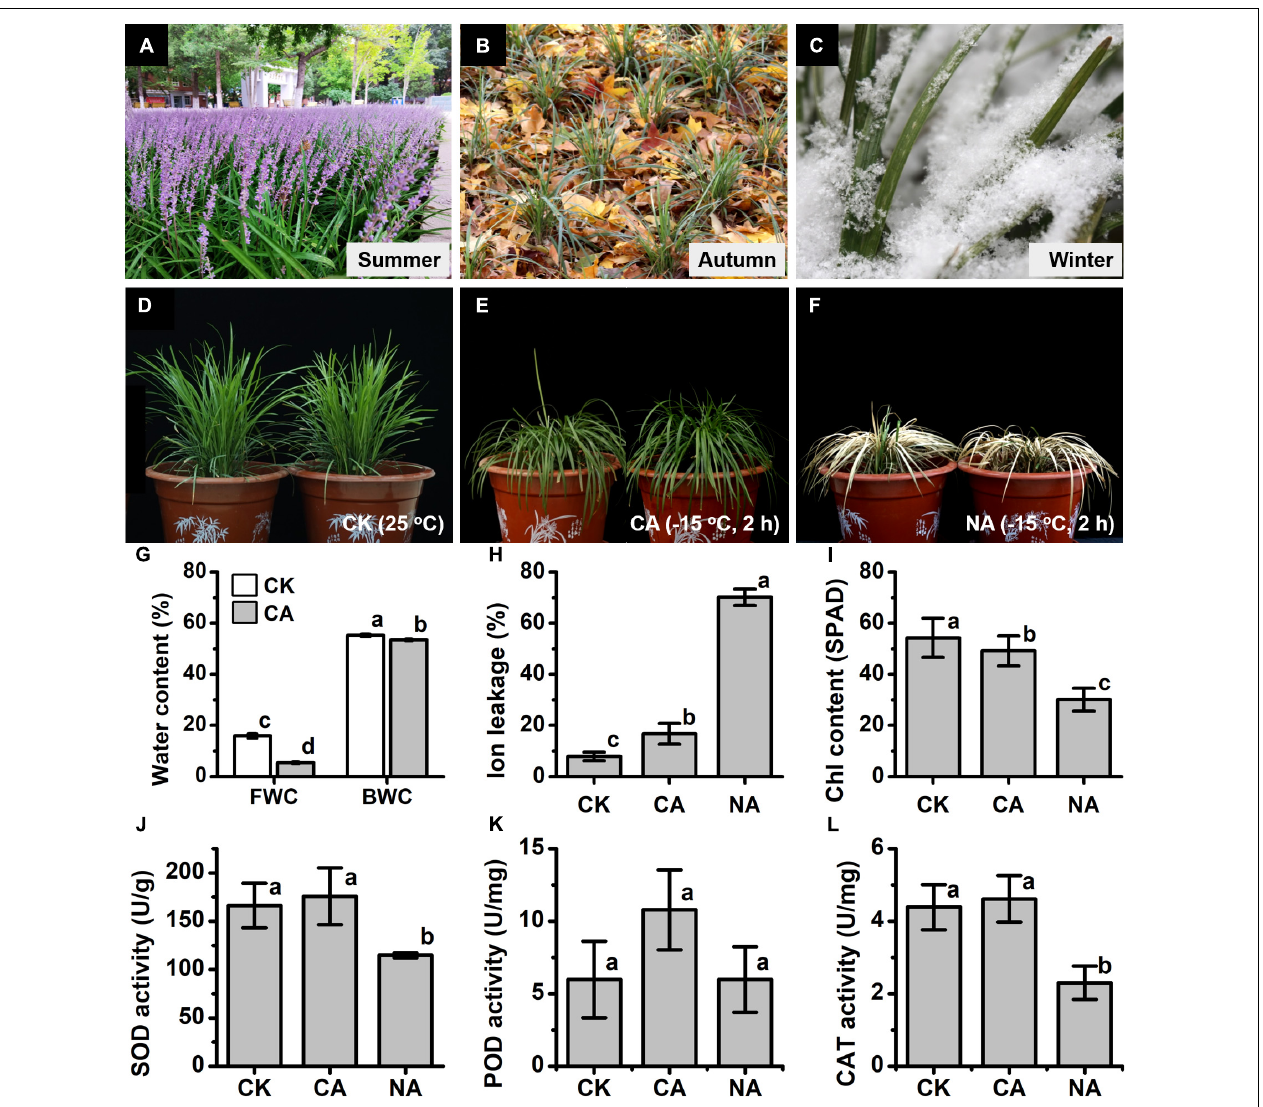
FIGURE 1 | Physiological and biochemical responses to the freezing stress in Liriope spicata . (A) Flowering landscape in summer. (B) Leaves of L. spicata do not turn yellow in autumn. (C) Leaves remain fresh and green when covered by heavy snow in winter. (D) Normal phenotype under 25 ◦ C (CK) condition. (E) Freezing phenotype under cold-acclimation (CA) conditions. (F) Freezing phenotype under non-acclimation (NA) conditions. (G) Water physiology. FWC, free water content; BWC, bound water content. (H) Ion leakage. (I) chlorophyll (Chl) relative content. (J) superoxide dismutase (SOD) enzyme activity. (K) Peroxidase (POD) enzyme activity. (L) Catalase (CAT) enzyme activity. CK, control samples that culture under 25 ◦ C; CA, freezing treatment samples under –15 ◦ C 2 h with 4 ◦ C CA for 3 days priority; NA, freezing treatment samples under –15 ◦ C 2 h without 4 ◦ C CA. The letters a,b,c in (G–L) represent significant differences among the samples; Student’s t -test, p <